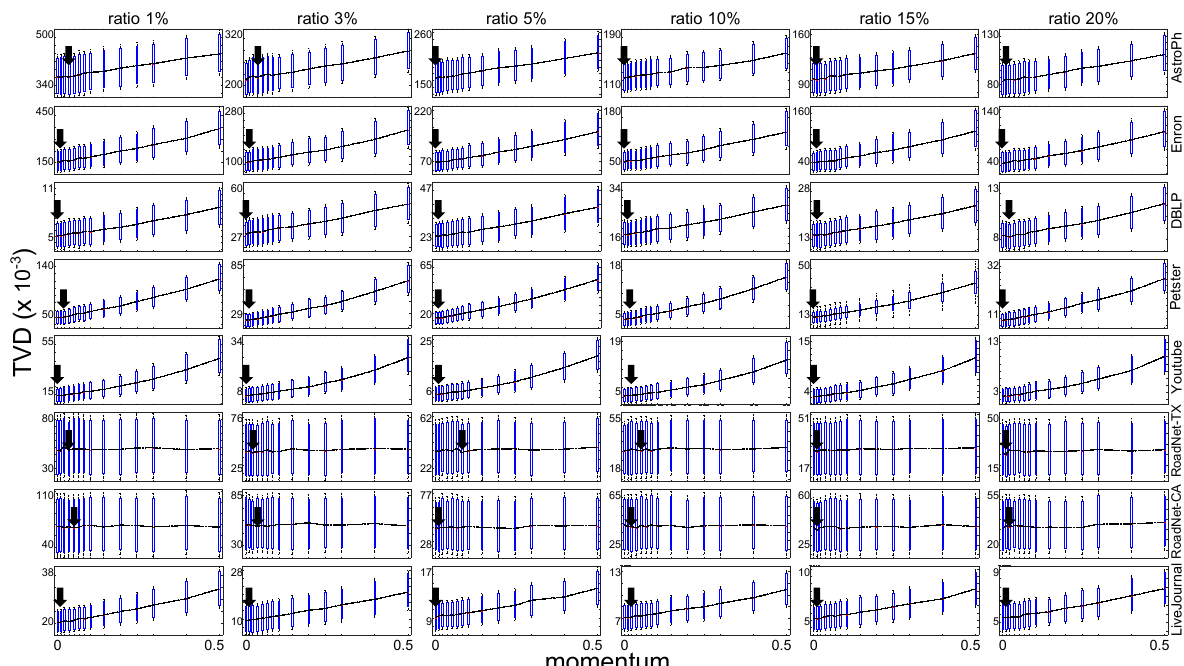
Figure 5. Sampling results obtained with various momentum parameters on real–world network databases.